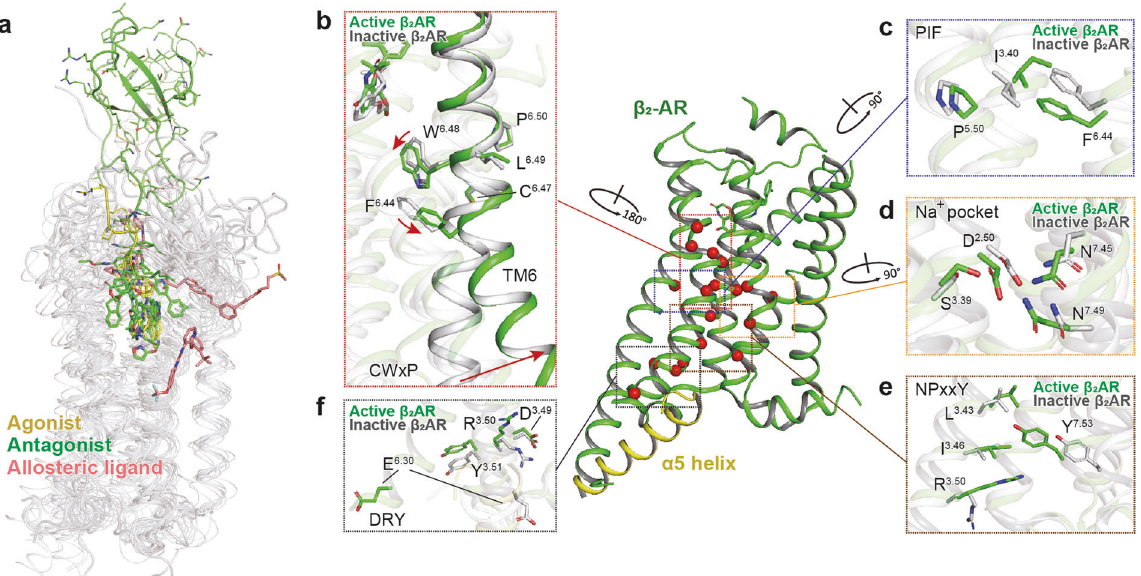
Fig. 5 Structural features and common activation mechanism of class A GPCRs. a Ligand-binding pockets. Agonist, antagonist, and allosteric ligand are indicated as sticks in yellow, green, and salmon, respectively. Ligands are shown from the following structures (PDB code): 2RH1, 3PWH, 3VW7, 4IAR, 4MQT, 4PHU, 4RWS, 4XEE, 4XNV, 4Z35, and 4ZJ8. b – f The common activation pathway of class A GPCRs as exampled by the structures of inactive (gray, PDB code 3NYA) and active β 2 AR (green, PDB code 3SN6). The conformational changes of conserved “ micro- switches ” , including CWxP ( b ), PIF ( c ), Na + pocket ( d ), NPxxY ( e ), and DRY ( f ), are highlighted. Side chains of residues in “ micro-switches ” are shown as sticks. Red arrows indicate the shift and swing directions of elements in the active β 2 AR structure relative to the inactive